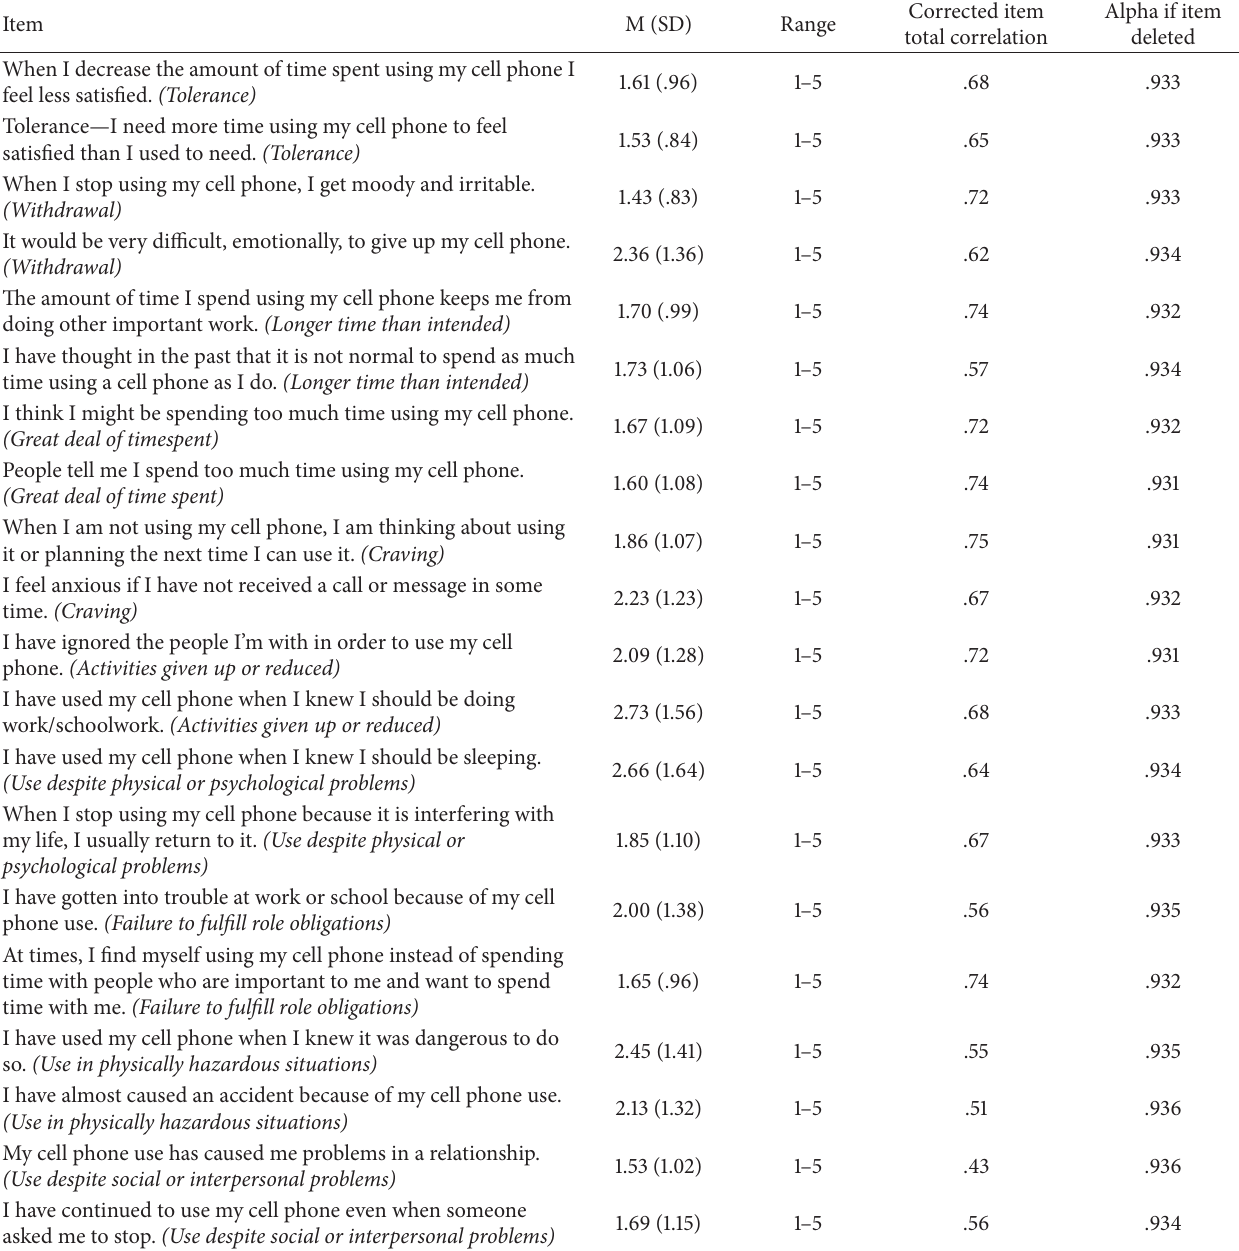
Table 2: PUMP Scale item